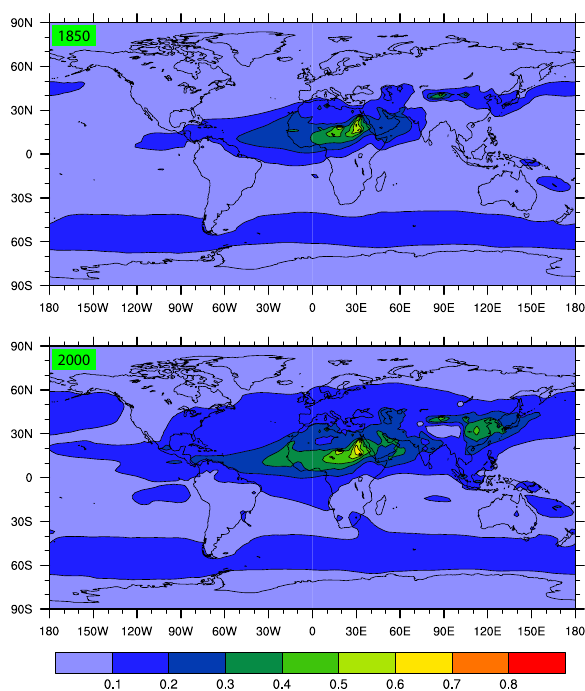
Fig. 10. Total (natural and anthropogenic) CAM-chem simulated aerosol optical depth at 550nm (decadal average) for 1850 and 2000.